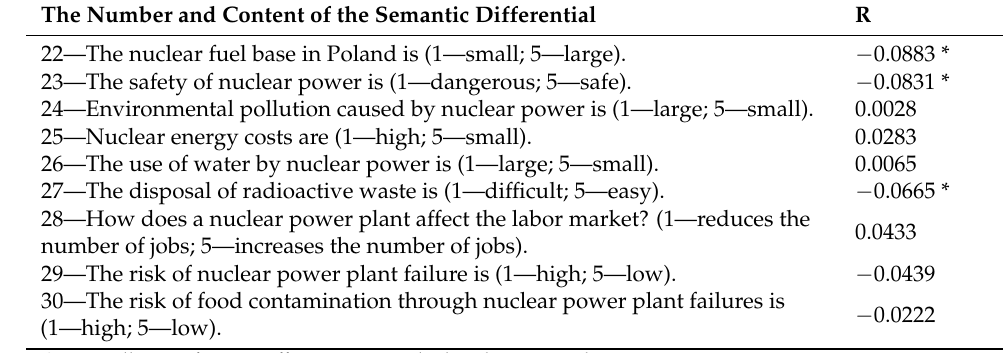
Table 9. Values of Pearson’s correlation coefficients between the assessments of the semantic differen- tial and the age of the respondents * (own